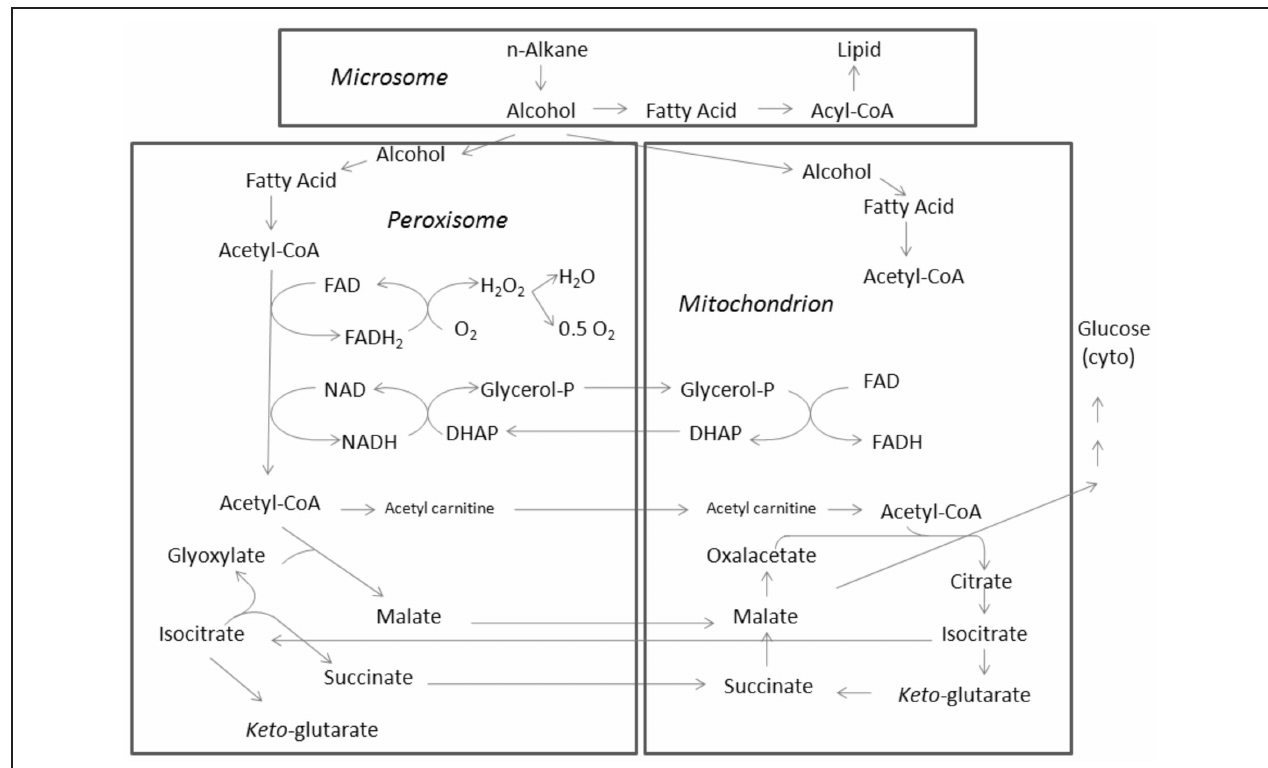
FIGURE 4 | Sub-cellular distribution of hydrocarbon catabolic